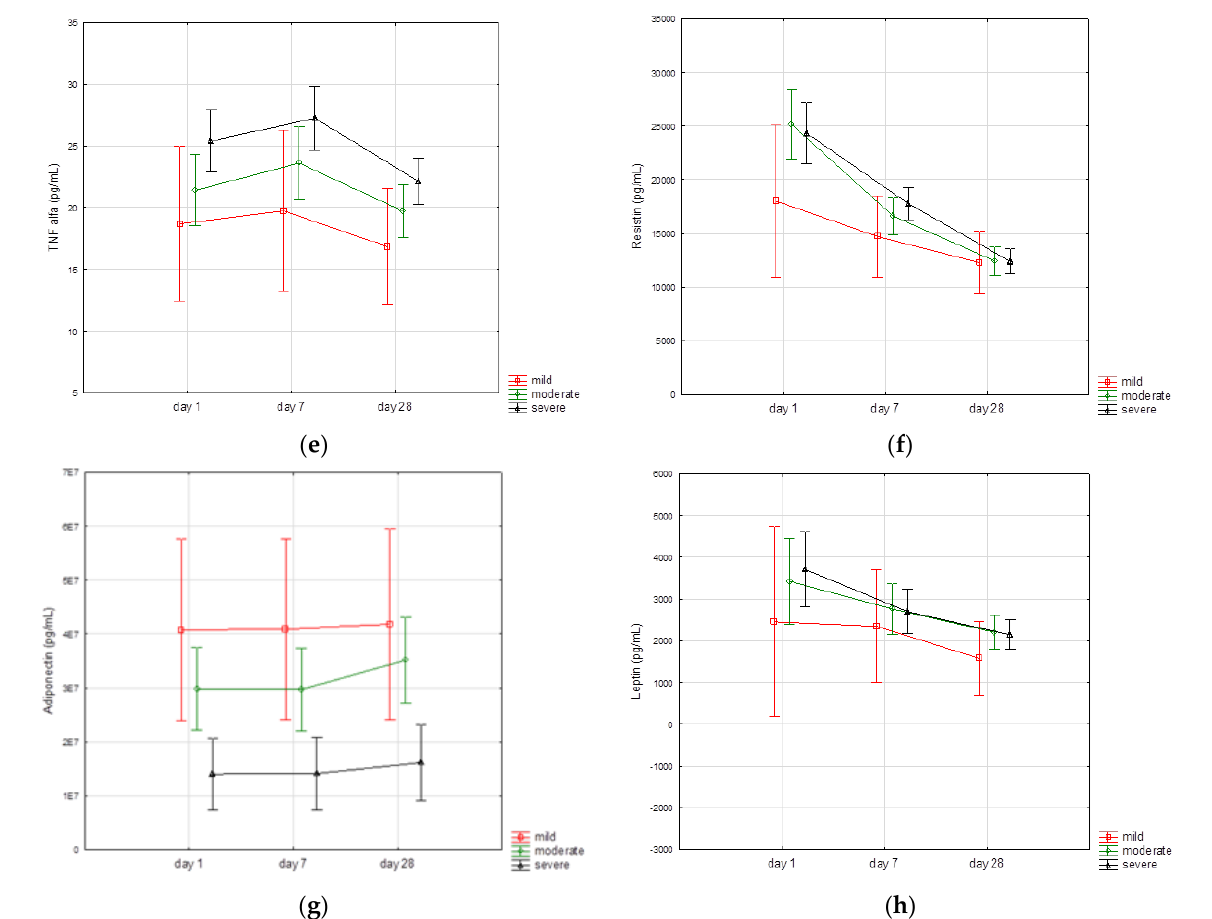
Figure 1. Time course of biomarker concentrations according to the clinical spectrum of SARS-CoV2 infection. ( a ) Chemerin; ( b ) angiopoietin 2; ( c ) Pentraxin 3; ( d ) IL- 1β; ( e ) TNFα; ( f ) resistin; ( g ) adiponectin; and ( h ) leptin. Vertical bars represent 95% confidence intervals for the mean. Il- 1β, interleukin 1 beta; TNFα, tumor necrosis factor alfa.